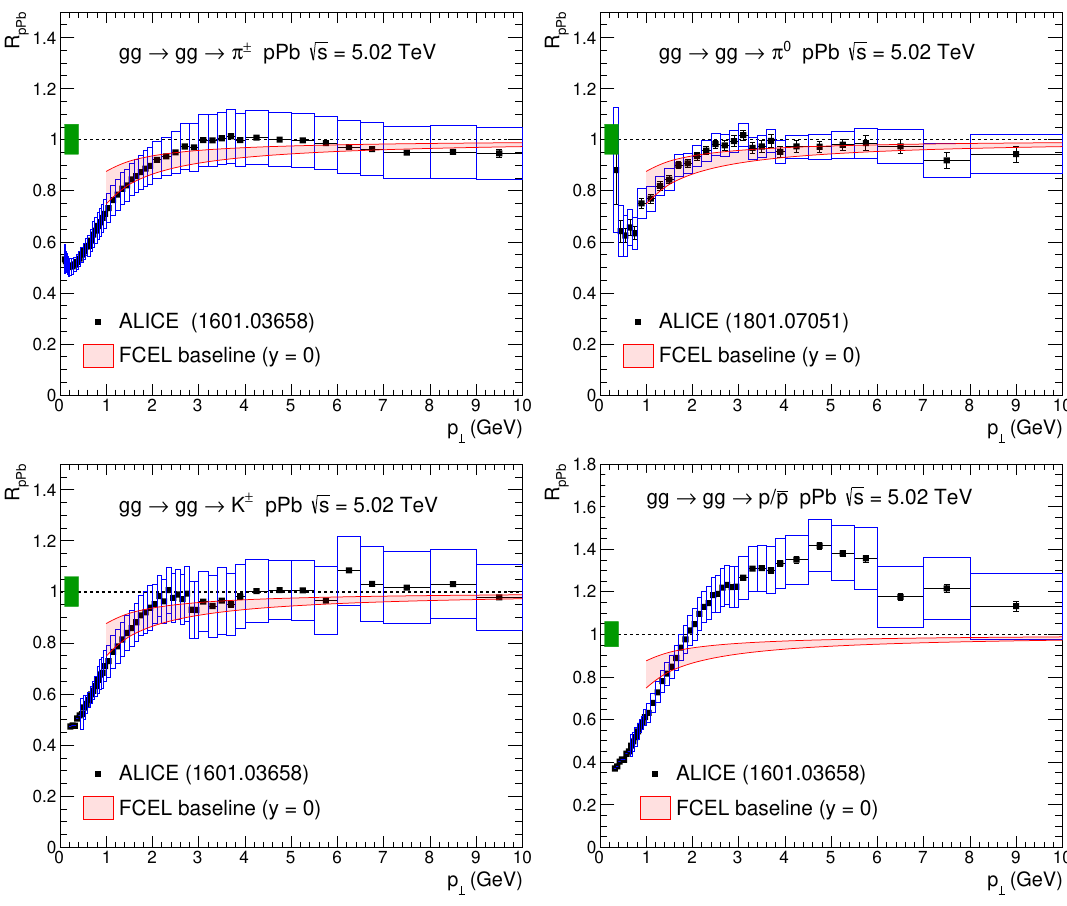
Figure 5 . Nuclear modi(cid:12)cation factor (3.13) in pPb collisions at p s = 5 : 02 TeV (red band) in comparison to ALICE charged pion data (top left) [79], neutral pion data (top right) [80], charged kaon data (bottom left) [79], and proton/antiproton data (bottom right) [79]. The baseline calculation assuming FCEL e(cid:11)ects only is done in the gg gg channel and at y = !